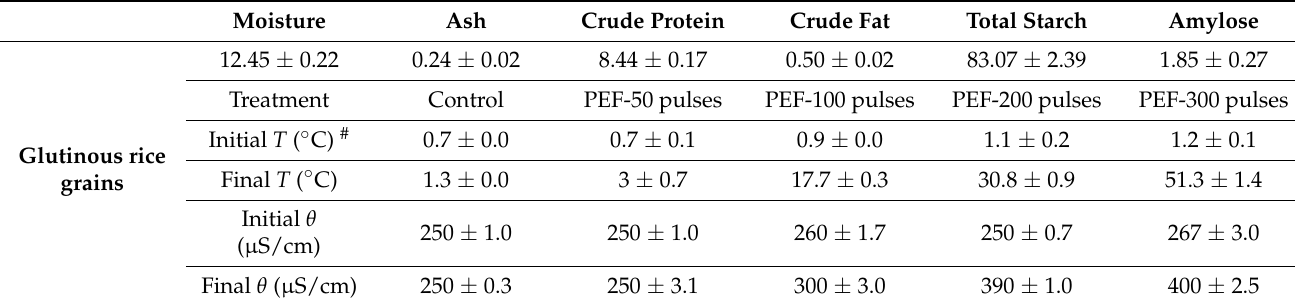
Table 1. Proximate composition of glutinous rice grains (wt.%, dry weight basis), and the temperature of rice grains suspensions before and after pulsed electric field (PEF) treatment *. Moisture Ash Crude Protein Crude Fat Total Starch Amylose 12.45 ± 0.22 Treatment Control PEF-50 pulses PEF-100 Glutinous rice grains